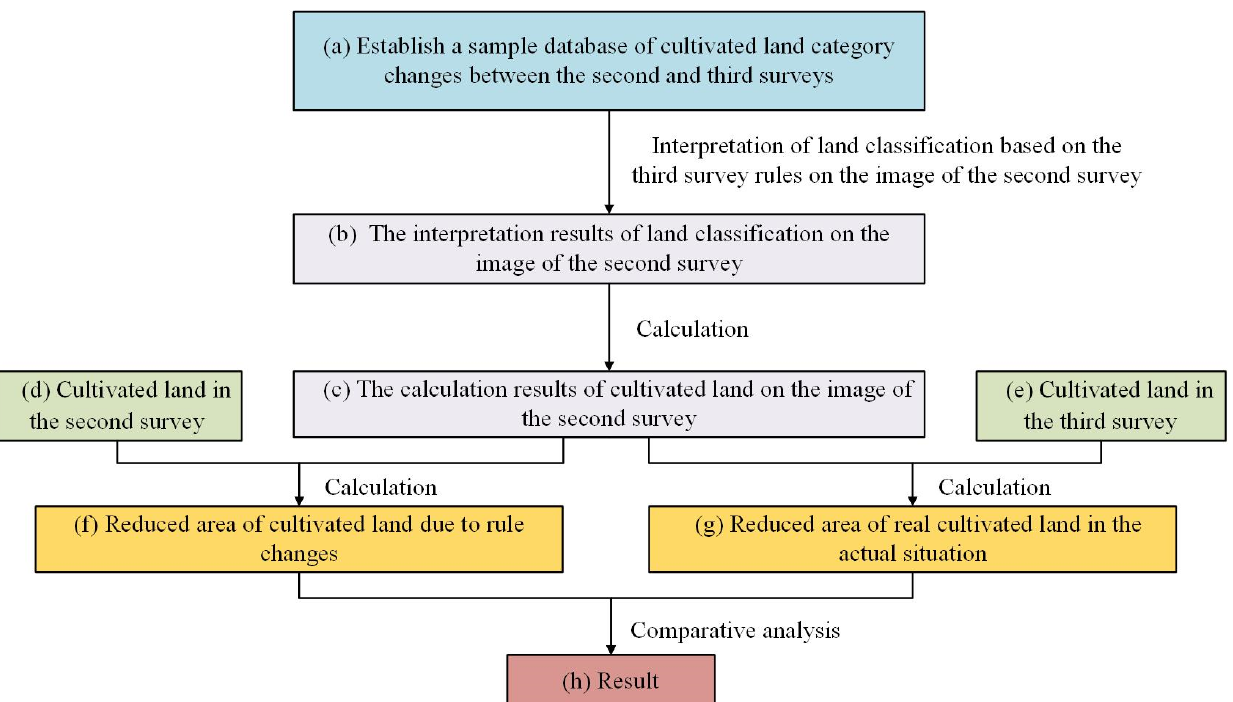
Figure 2. Technical roadmap.